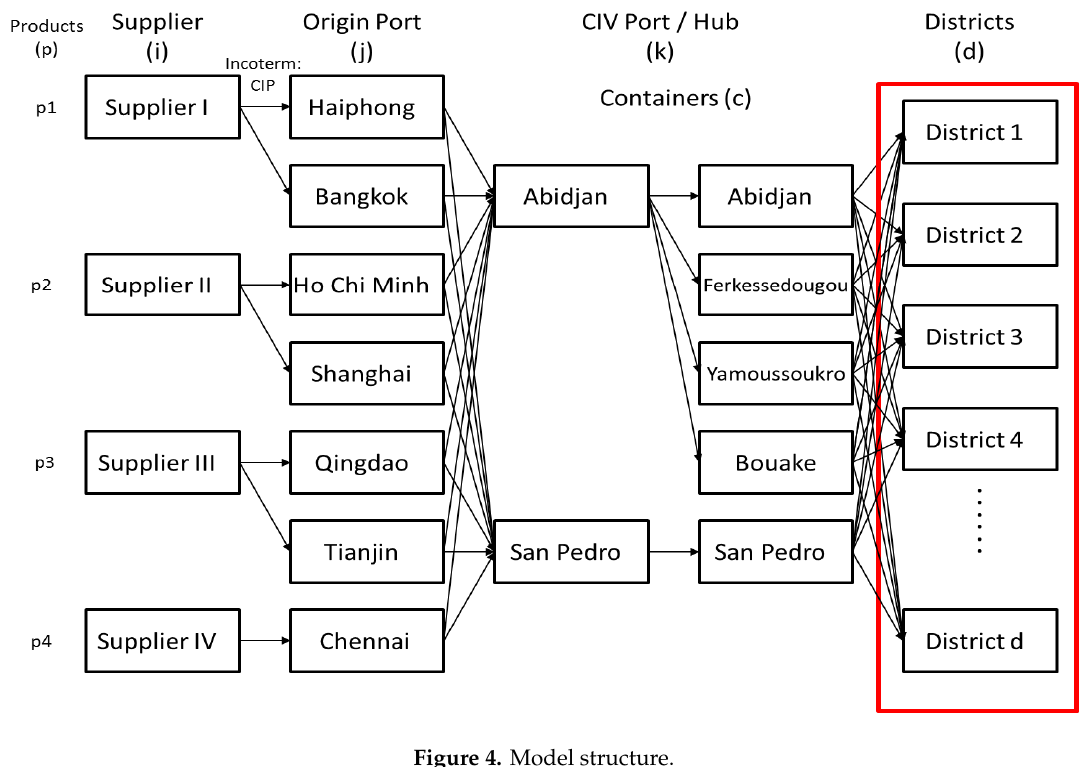
Figure 4. Model structure.